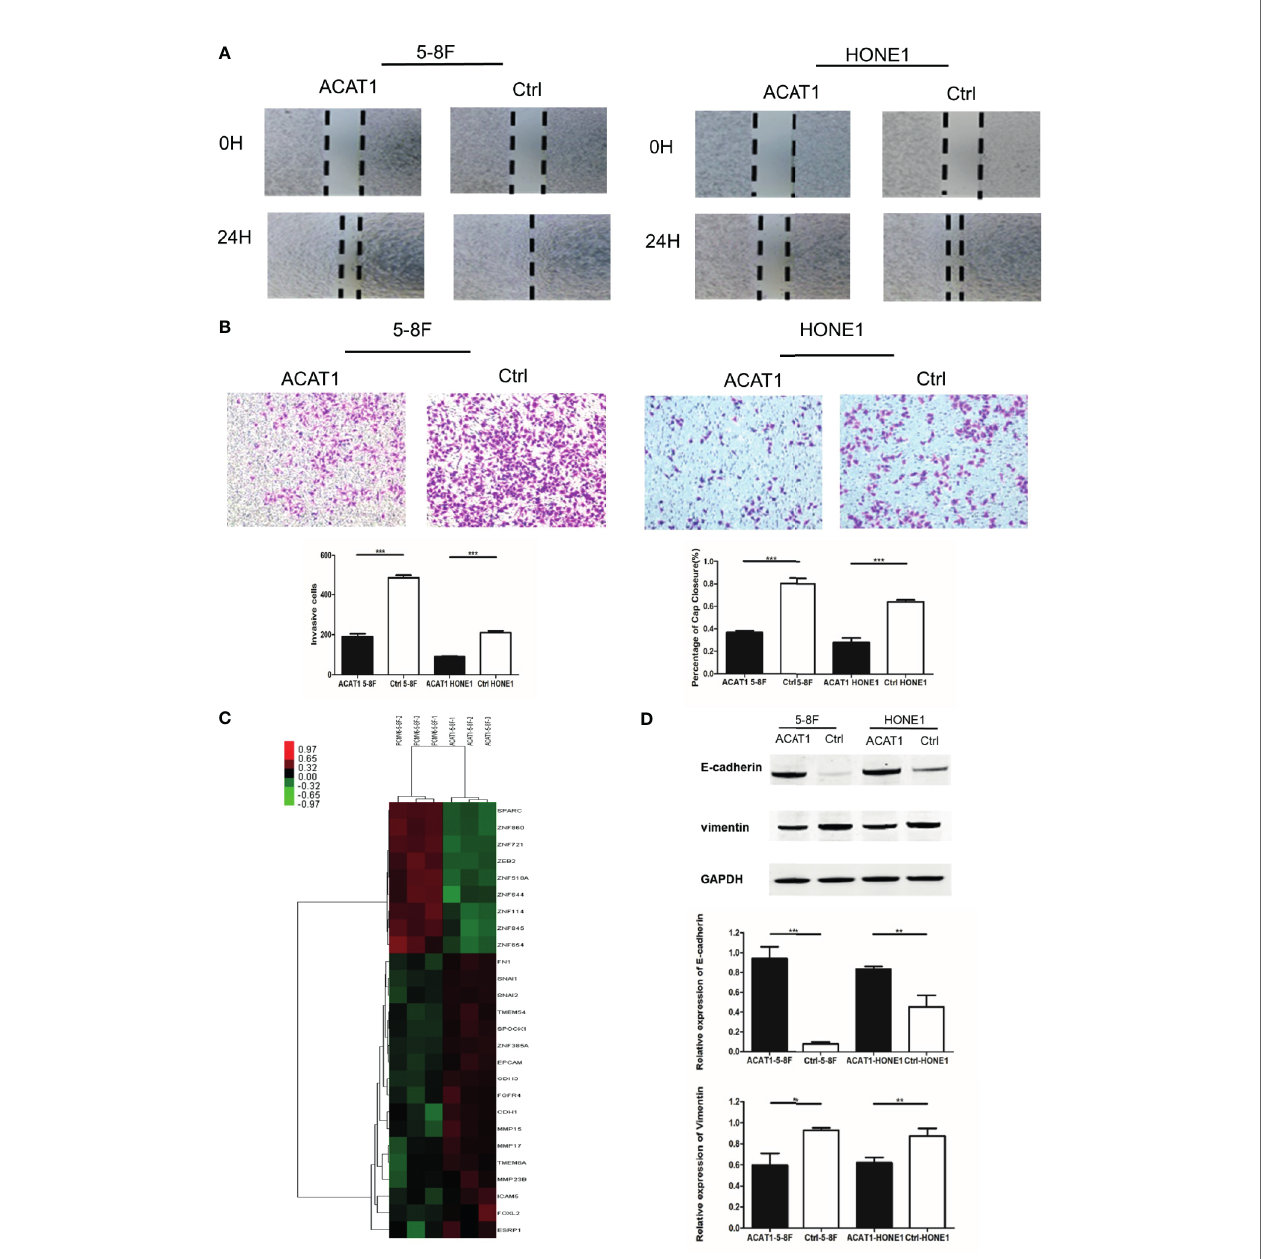
FIGURE 6 | Overexpression of ACAT1 suppresses the migration and invasion of NPC cell lines in vitro by reversing EMT. (A) Migration of NPC cells stably transfected with ACAT1 or empty vector was examined by a wound-healing assay. The gap closure was photographed and measured at 0 and 24 h. The percentage of wound width for each sample was calculated by ImageJ software. Magni fi cation ×100. (B) Invasion of NPC cells stably transfected with ACAT1 or empty vector was examined by transwell assay. The blue dots represent the invading cells stained with crystal violet. The number of invading cells was counted and is shown in the bar graph. (C) cDNA microarray data: heatmap showing expression of 26 genes involved in EMT in ACAT1-overexpressing 5-8F cells as compared with pCMV6-Entry-5-8F cells. (D) The expression of E-cadherin and Vimentin was detected by western blot and quantitated by densitometric scanning. GAPDH was used as an internal control. Data are expressed as means ± s.d. in a bar graph. The independent Student ’ s t-test was used to analyze the results and data are expressed as the means ± SD. ** p < 0.01, *** p <